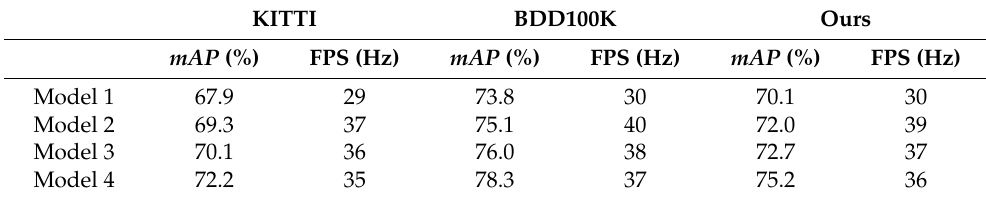
Figure 11. The visualization of vehicle – pedestrian detection results in the traffic scene. ( a ) are the detection results of the original YOLOv4, ( b ) are the results of the improved YOLOv4 (Model 4). Table 2. Experimental comparison on different datasets.